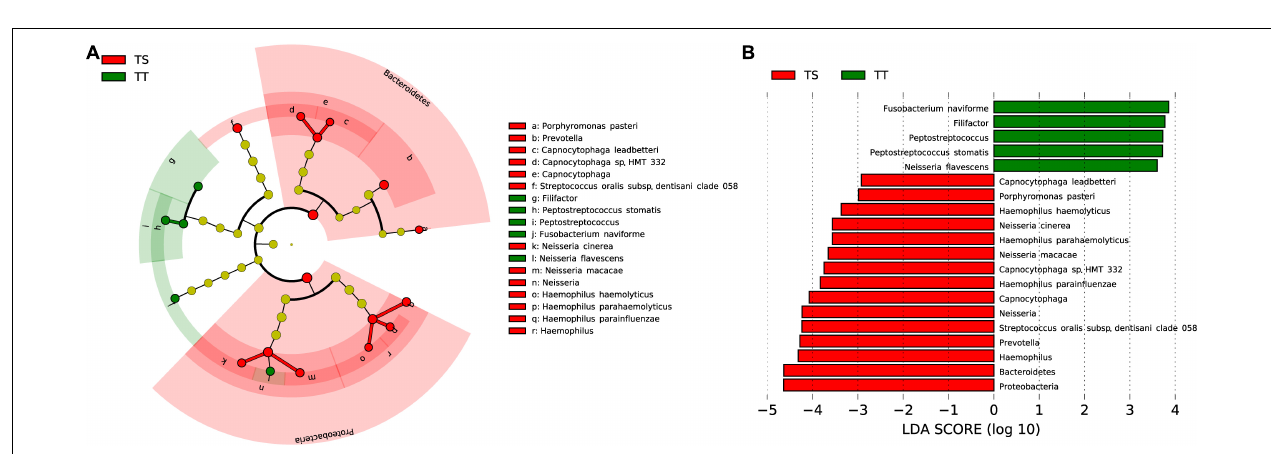
FIGURE 3 | Comparative taxonomic profile of TT and NPT groups. (A) The cladogram showed differently enriched taxa. (B) LDA scores computed for differentially abundant taxa between TT and NPT groups (Log10 LDA scores > 2). The phyla, genera, and species with significant richness differences (FDR < 0.05) between the two groups are shown.